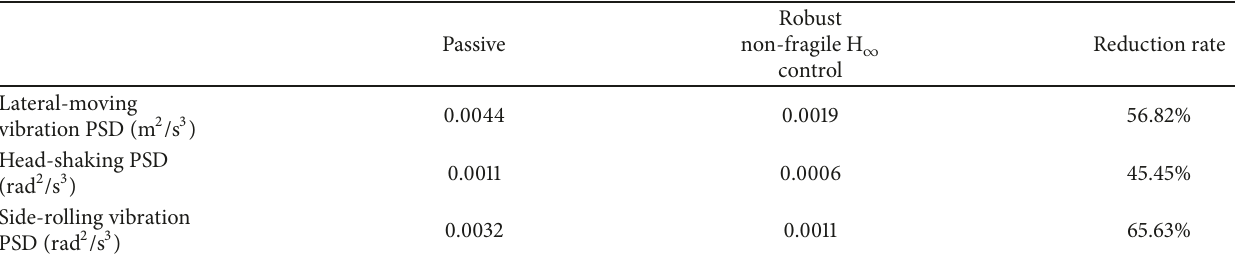
Table 3: Acceleration power spectral density maximum